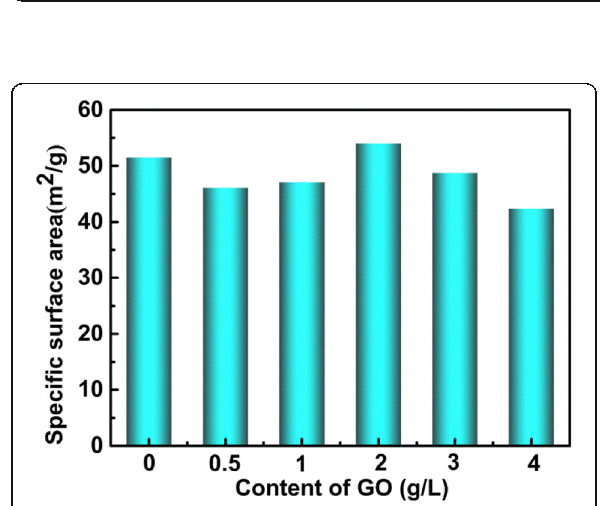
Fig. 5 The BET specific surface areas of Bi 2 WO 6 and